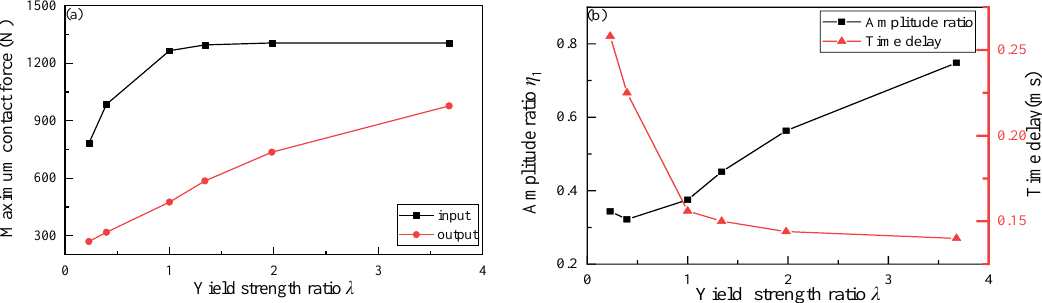
Figure 9. The impact buffering performance in Part II: ( a ) maximum contact force; ( b ) amplitude ratio and the time delay.